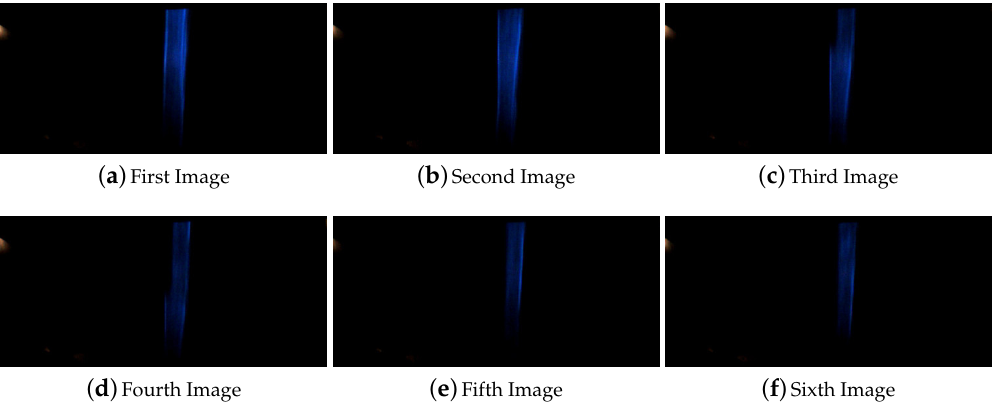
Figure 14. Sequence of images for the reduction of the line width to 3.5 cm.